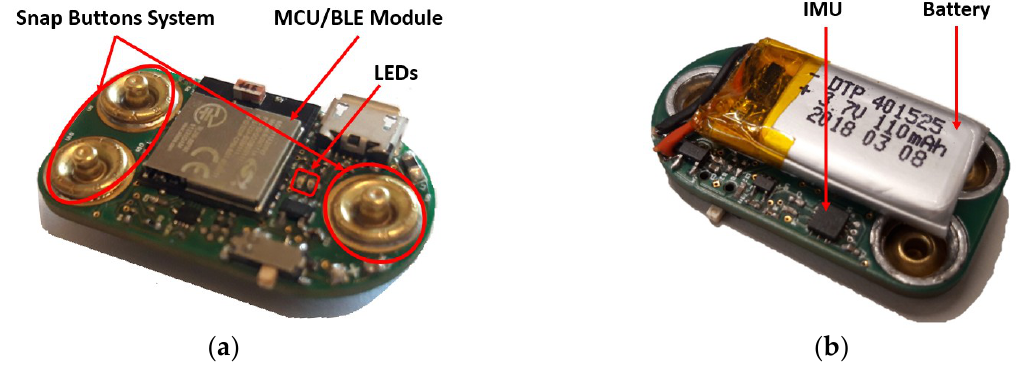
Figure 4. Hardware inertial unit: ( a ) Top view with the microcontroller unit (MCU) / Bluetooth Low Energy (BLE) module, snap buttons system, on/off button and USB entry for device charging; ( b ) Bottom view with a small battery and the Inertial Measurement Unit.